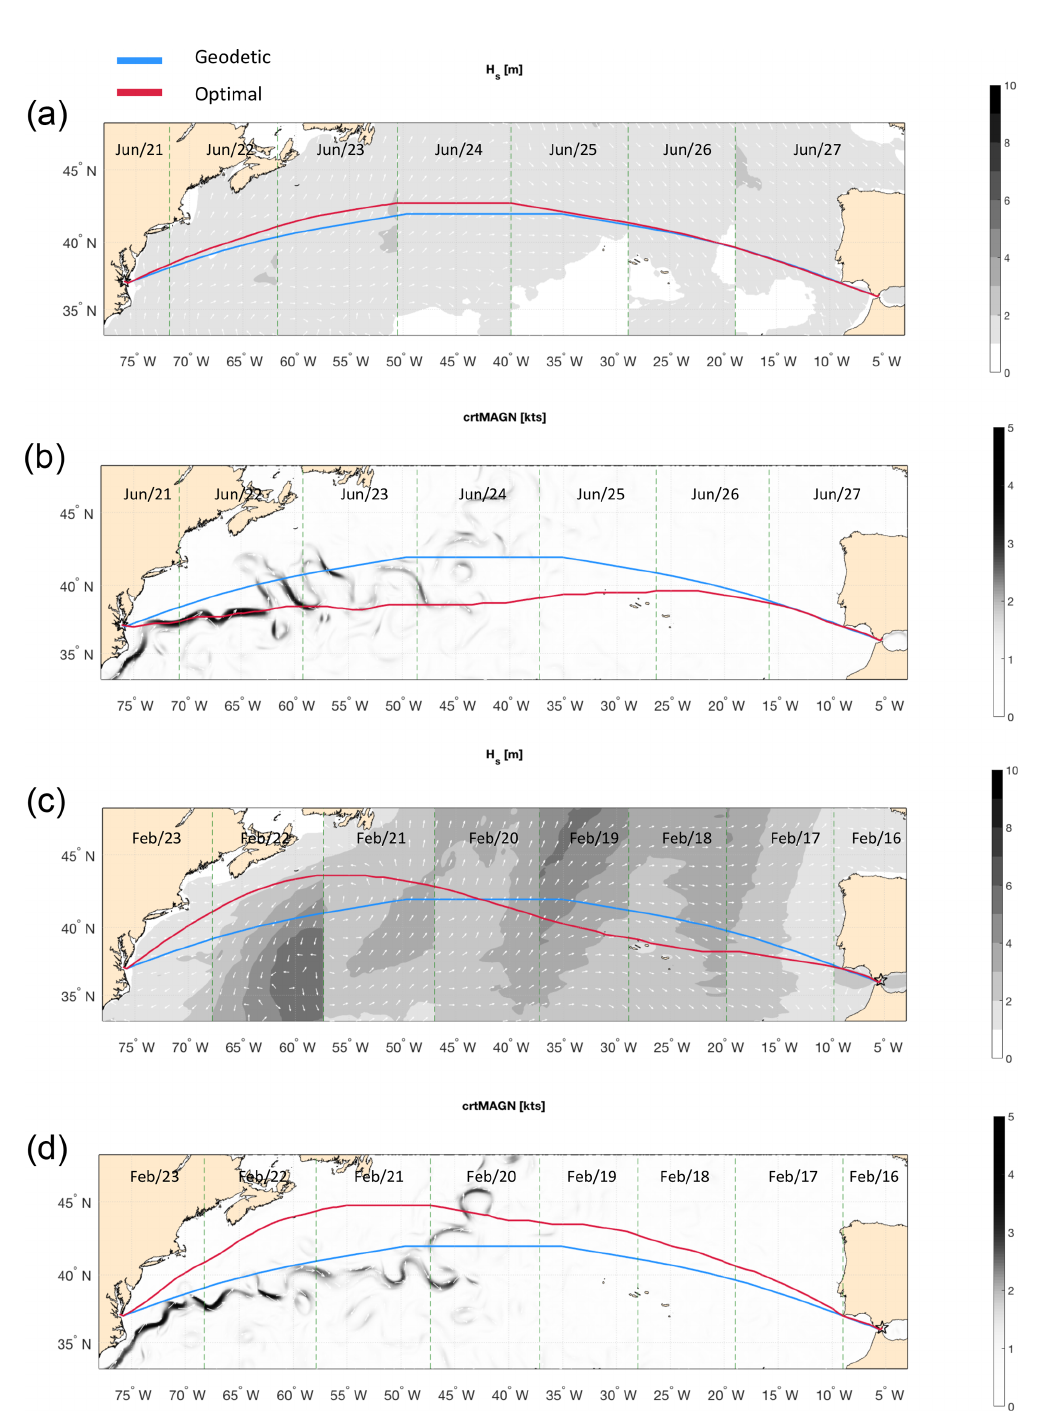
Figure 5. Geodetic (blue) and optimal tracks (red) for the USNFK–ESALG route in the presence of different environmental forcings and departure dates: panels (a) and (c) are of w type, H s is displayed as shading, and wave direction is displayed as white arrows. Panels (b) and (d) are of cw type, current magnitude is displayed as shading, and its direction is displayed as white arrows. Departure date is 21 June for (a) and (b) and 16 February for (c) and (d) . Departure time is 12Z (12:00UTC) for all tracks. All panels are split into vertical stripes relative to daily time steps of the optimal tracks – the interface between stripes is marked by a green dashed line. Summary data are reported in Table